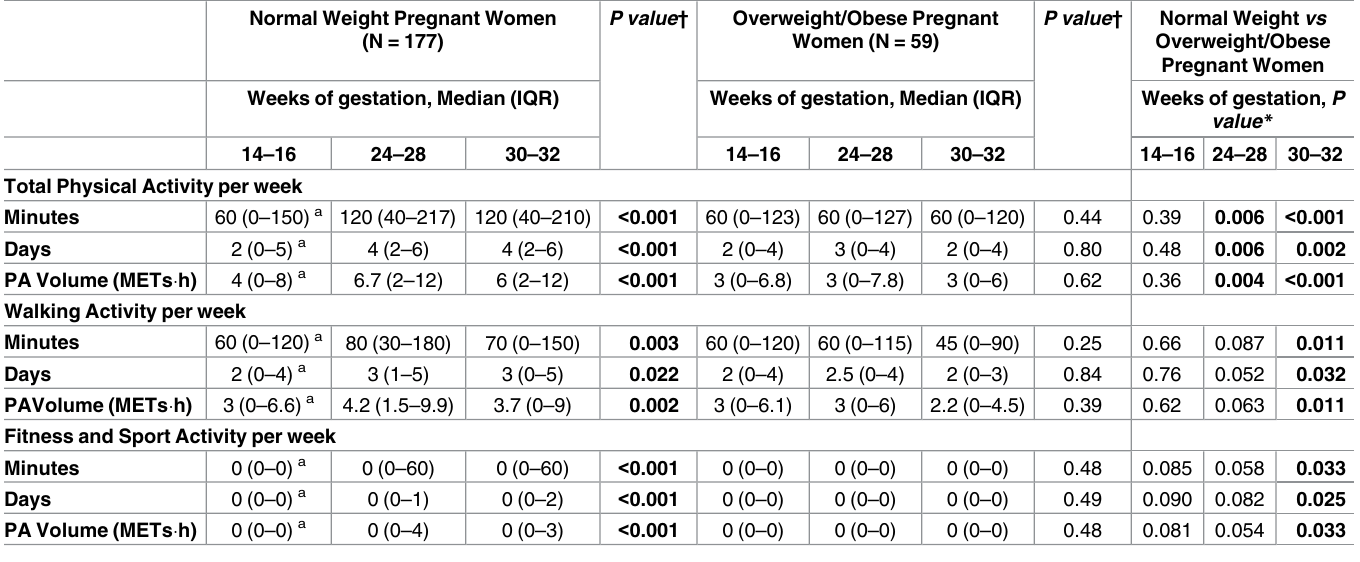
Table 2. Weekly physical activity across gestation in normal weight and overweight/obese pregnant women. Data are expressedas minutes of PA per week, days per week in which PA was performed, and total volume of PA, expressed in METs (cid:1) hours per week. Normal Weight Pregnant Women (N =